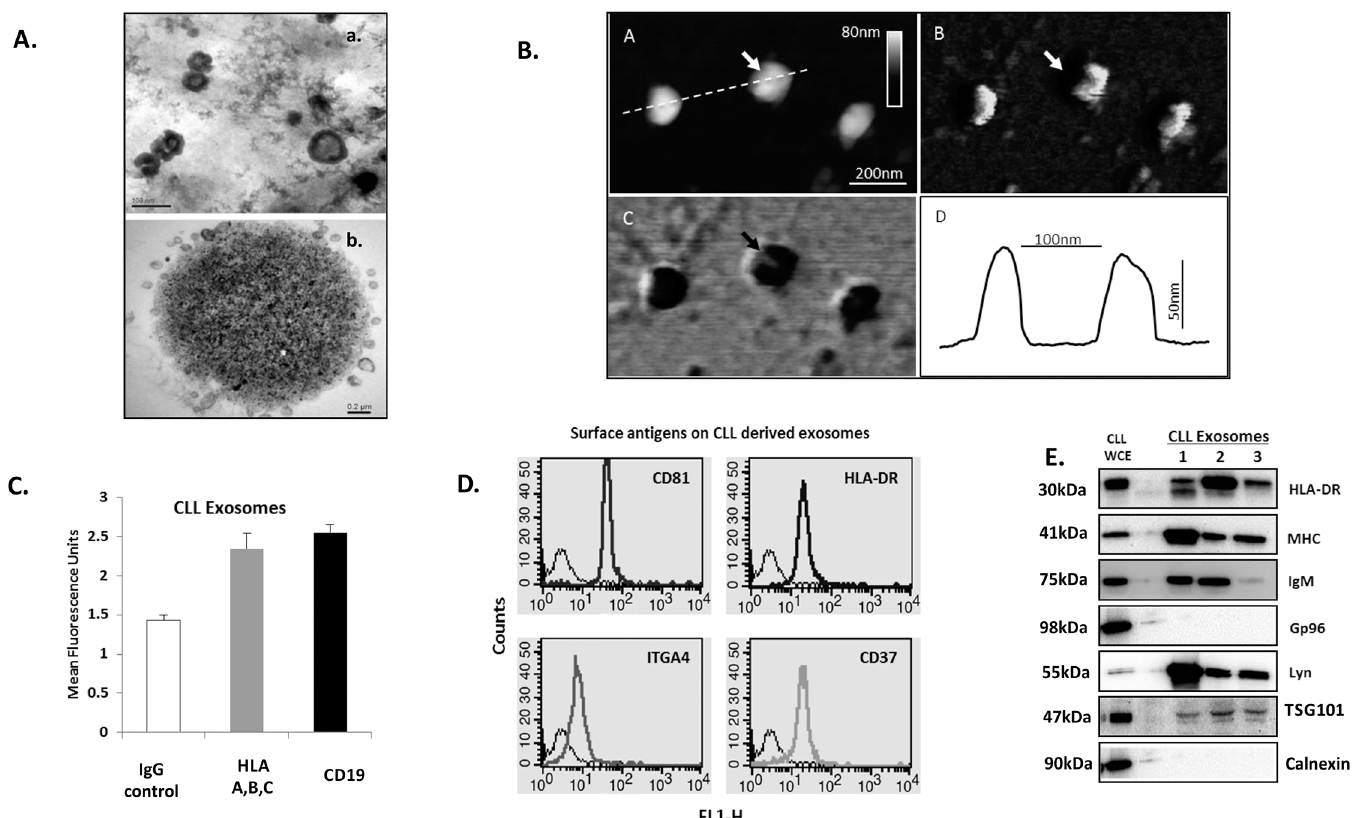
Fig 1. Characterization of CLL derived exosomes. A) Transmission electron microscopy (TEM) image of exosomes enriched from CLL cell culture medium after 48 hrs. (a) Exosomes are visible as small 50 – 100 nm vesicles with bi-layered membranes (scale bar: 100 nm). (b) Exosomes were immune- isolated using magnetic beads coated with anti-HLA antibody and ultrathin sections of resultant beads processed for image analysis. The representative TEM image shows a bead coated with exosomes (scale bar: 0.2 μ m). B ) AFM images of exosomes from a representative CLL case immobilized on a mica surface using Peakforce Tapping mode (Multimode 8, Bruker). A) Topographic image of exosomes. B ) DMT Modulus image C) Adhesion image: The exosomes appear as circular biconvex vesicular structures. The DMT Modulus and adhesion images of exosomes show explicit sub-structures at the centre of the vesicles (arrows). D) Schematic cross-section following the line in the indicated exosome in C). C) FACS analysis of B-cell antigens on CLL exosomes prepared from primary CLL cases by density ultracentrifugation and adsorbed onto 4 μ m aldehyde-sulphate latex beads and incubated with isotype control, anti-HLA-A, B, C or CD19 antibodies followed by FITC-conjugated secondary antibody. Mean fluorescence intensities are plotted (mean ± standard error of mean (S.E.M.) (n = 9)). D) Representative analysis showing surface expression of CD81, HLA-DR, CD37, and integrin α 4 (ITGA4) in CLL derived exosomes coupled to aldehyde-sulphate latex beads. Binding of FITC-conjugated isotype controls are included for comparison. E) Immunoblot analysis of CLL derived exosomes: Lysates from CLL exosome were probed for abundance of HLA-DR, MHC, IgM, Gp96, Lyn kinase, TSG 101 and Calnexin. Images are representative of analyses of 3 cases. WCE-Whole cell extract